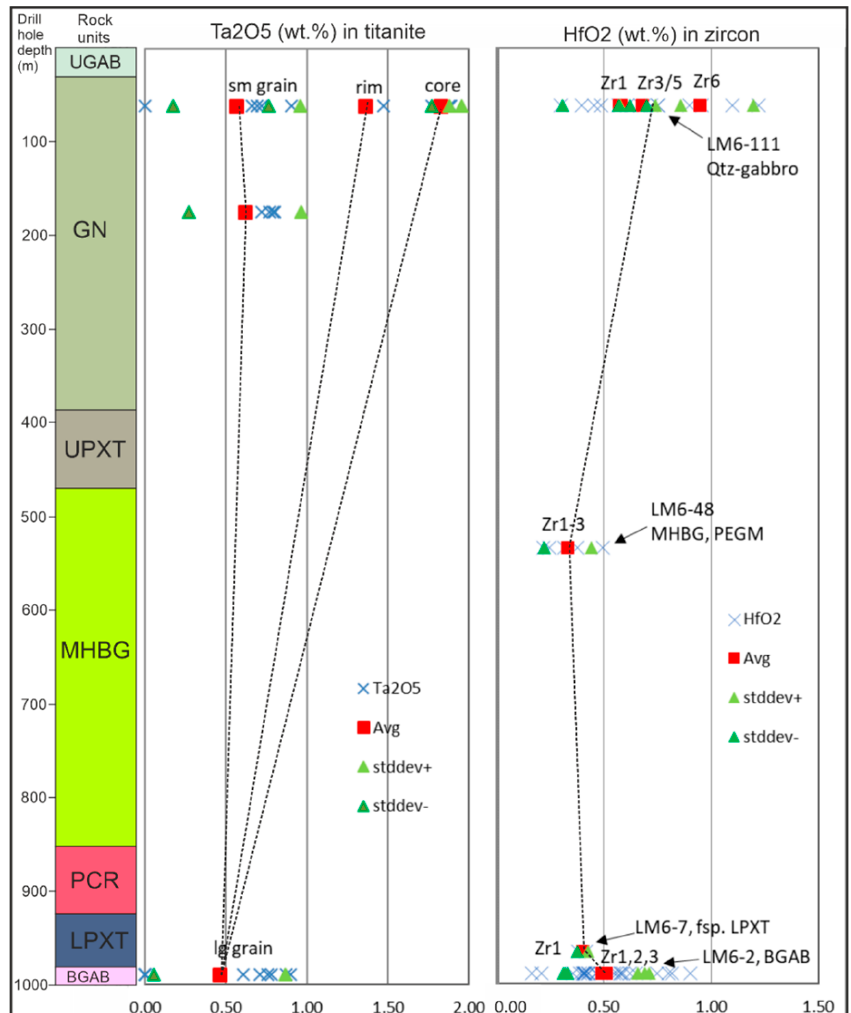
Figure 11. Trace elements in titanite, zircon (EPMA). Abbreviations: Rock units and types as in Figure 5. X Ta 2 O 5 / HfO 2 : single measurements, Avg: average value, stddev+/ − : average plus/minus standard deviation, sm: small, lg: large, Zr1: zircon grain no.1, Qtz: quartz, fsp: feldspathic, Pegma: pegmatitic.